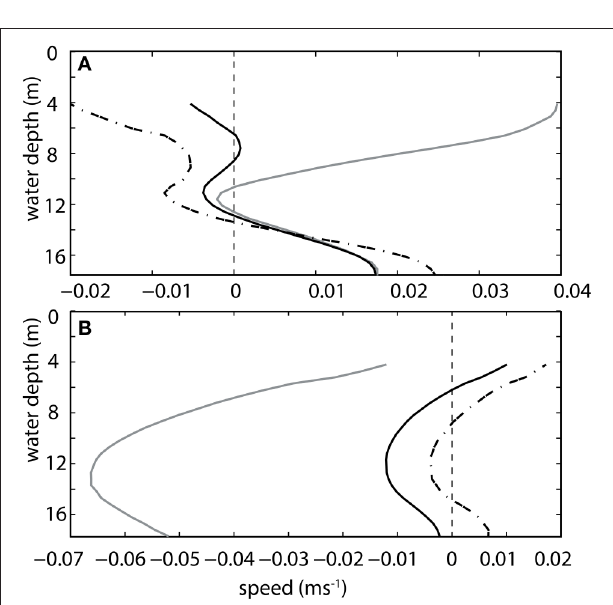
FIGURE 7 | Residual currents in the longitudinal direction at (A) WilsonB and (B) Waiheke for 12-months of ADCP observations (thick black line) and for a 38-day period in summer (dot-dashed line) and winter (thick gray